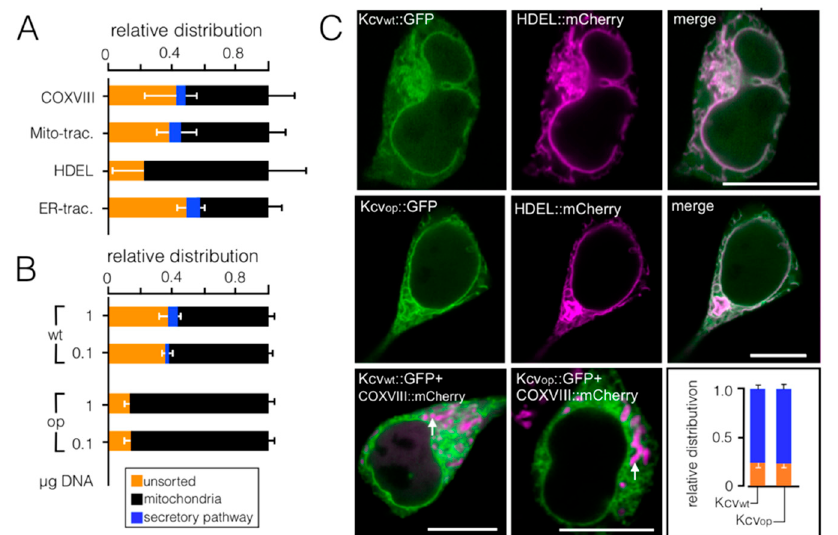
Figure 2. Codon-sensitive sorting is channel specific and not an artifact of the experimental system. ( A ) Mean relative distribution ± SD for localization of the Kesv channel in mitochondria (black), SP (blue), or unsorted (orange) in HEK293 cells transfected with Kesv wt . Images as in Figure 1 were analyzed by co-expression of the channel with marker proteins COXVIII::mCherry ( n = 4, n = 63 cells) or HDEL::mCherry ( n = 3, n = 55 cells) for mitochondria and ER, respectively. In separate experiments mitochondria and ER of Kesv wt transfected cells were labeled with fluorescent dyes Mito- ( n = 6, with ≥ 144 cells per condition) or ER-tracker, respectively ( n = 3, ≥ 116 cells per condition). ( B ) Mean relative distribution of Kesv wt and Kesv op in HEK293 as in C from cells transfected transiently with either 0.1 or 1 μ g DNA ( n = 3 with ≥ 121 cells per treatment). ( C ) Fluorescent images of HEK293 cells transfected with Kcv wt or Kcv op . Images in two top rows show: GFP tagged Kcv channels (green, first column), fluorescence from ER marker HDEL::mCherry (magenta, first and second row) and overlay of magenta and green channels in third column. Images in the third row show overlay of the GFP (green) and COXVIII::mCherry (magenta) channel for HEK293 cells transfected with either Kcv wt or Kcv op . Inset: Mean relative distribution (n ≥ 220 cells) for localization of the channel in SP (blue), or unsorted channels (orange) in HEK293 cells transfected with Kcv wt or Kcv op . Scale bars 10 μ m.